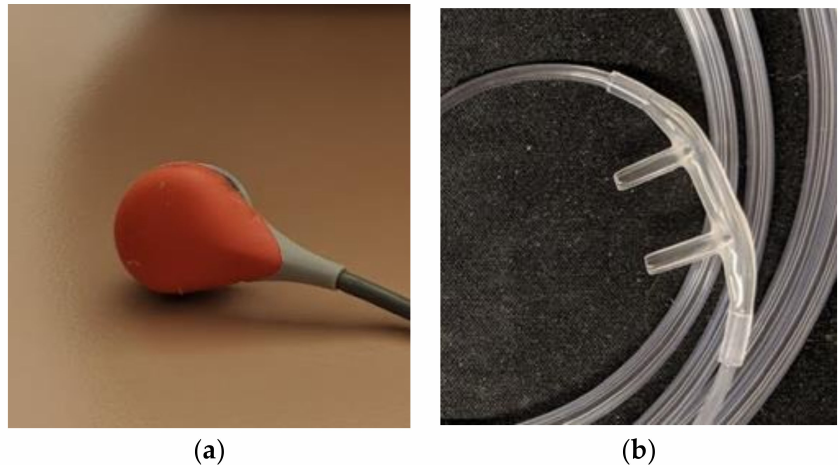
Figure 7. Noninvasive adjuncts used to measure CO 2 levels during overnight polysomnograms. ( a ) Transcutaneous CO 2 probe, which is applied to the skin; ( b ) nasal cannulae, which is inserted in the nares to measure end-tidal CO 2